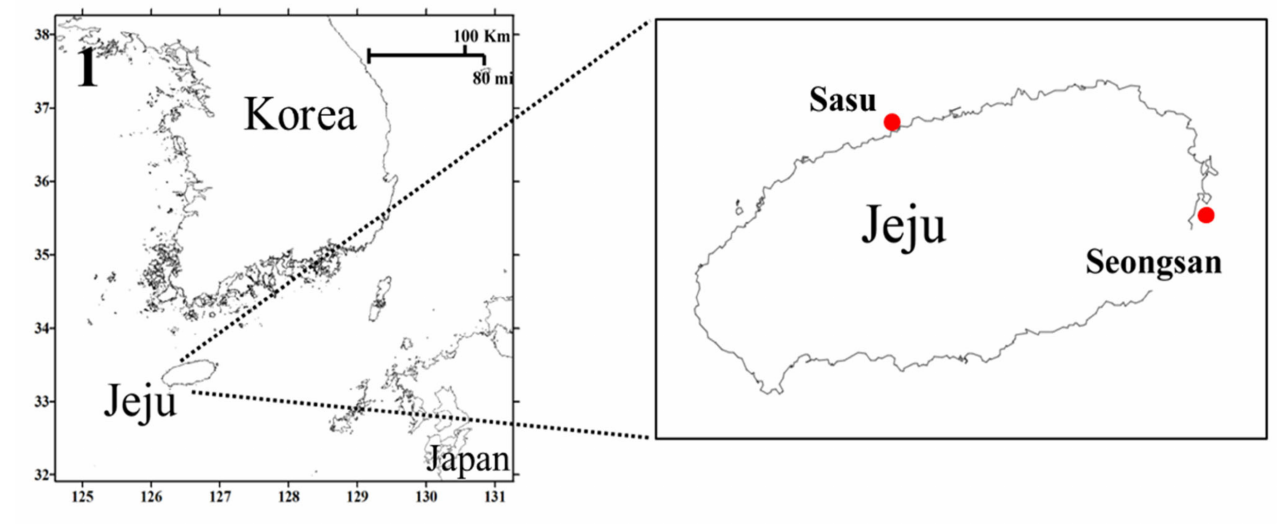
Figure 2. Map of Korea and Jeju Island indicating the sampling